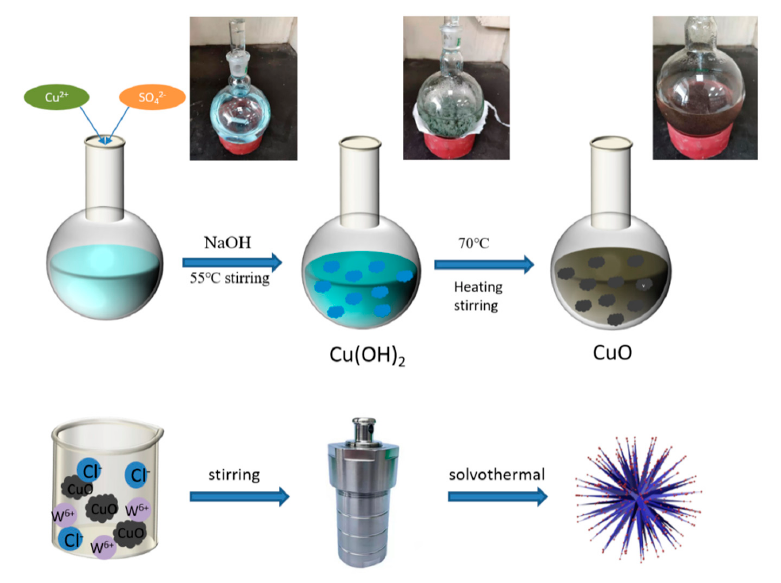
Scheme 1. Schematic illustration of the fabrication of the CuO/W 18 O 49